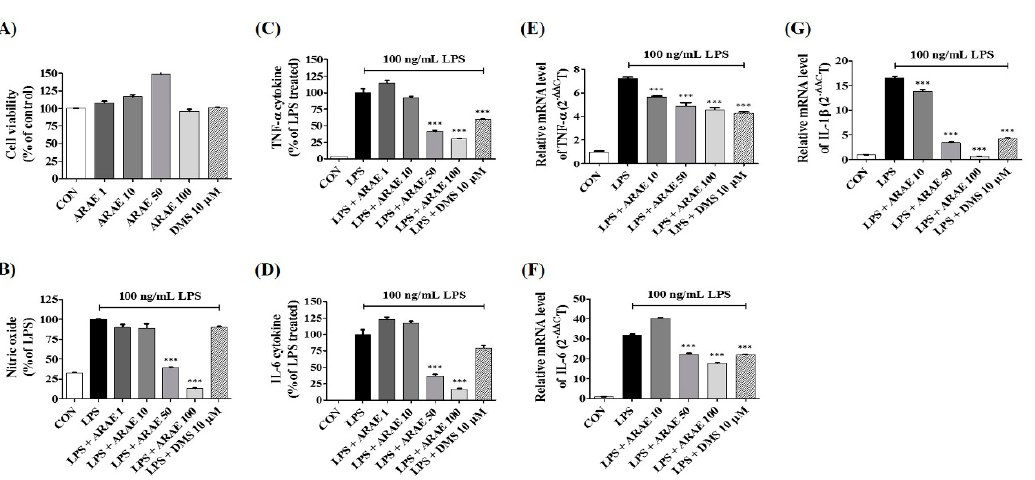
Figure 1. Effects of ARAE on ( A ) cell viability, ( B ) nitric oxide (NO) secretion, ( C , D ) inflammatory cytokines production, and ( E – G ) mRNA expression in BV2 microglia. Cells were seeded on a